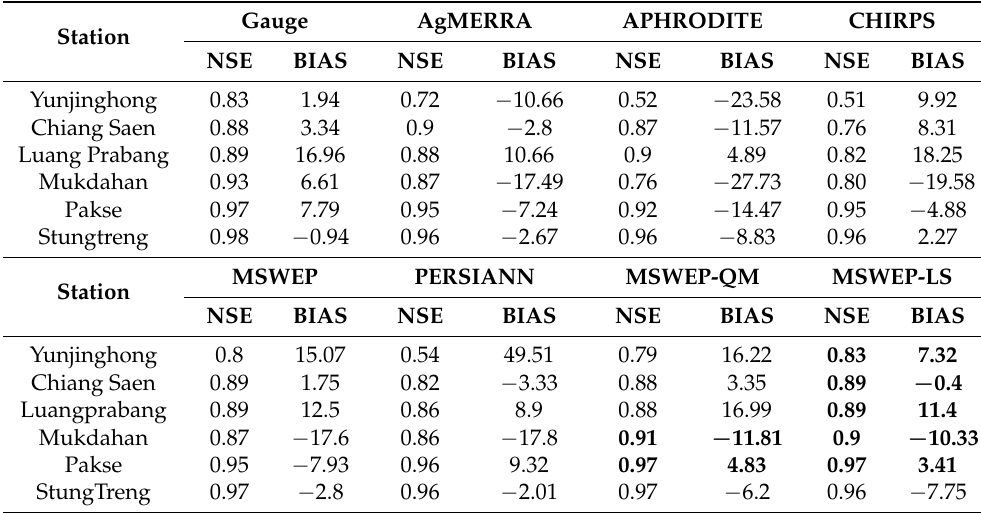
Table 4. Streamflow simulation results of six hydrological stations: NSE and BIAS (%). Station